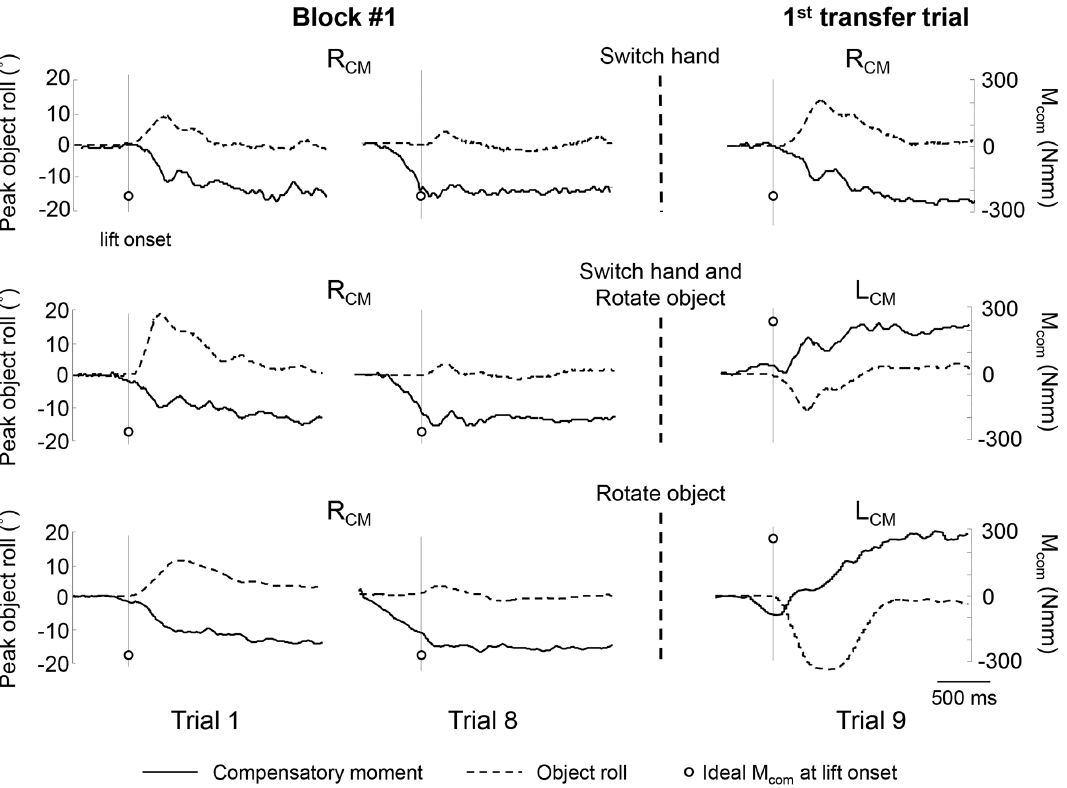
Figure 2. Compensatory moment and object roll. The figure shows the time course of compensatory moment (M com ; solid line) and object roll (dashed line) on pre-transfer trials (Block 1, Trials 1 and 8) and the first transfer trial (Block 2, Trial 1) from 3 representative subjects (S6, switch hand group; S23, switch hand and object rotation group; S28, object rotation group). All subjects started with the right CM. The solid vertical line in each panel denotes object lift onset. Circles denote the subjects’ ‘‘ideal’’ M com at object lift onset. The ideal M com is the M com that subjects should generate at object lift onset to neutralize the external moment generated by the mass added to the object. The left and right vertical axes refer to object roll and M com , respectively. Negative and positive values of object roll denote counterclockwise and clockwise roll relative to the vertical, respectively.